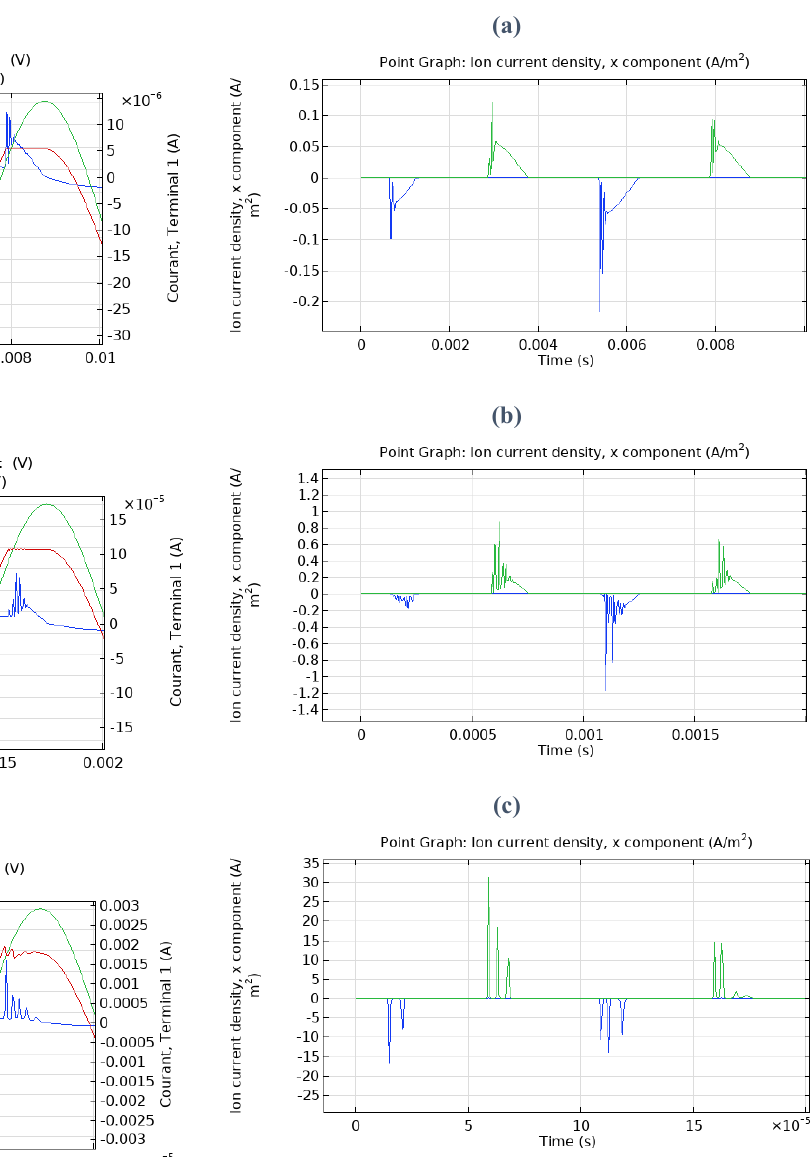
fig 6 : the variation of positive helium ion density, (in blue) next to the dielectric and (in green) next to the cathode with d = 0.5 mm and P = 760 Torr at different frequencies (a) 200Hz, (b) 1kHz and (c)